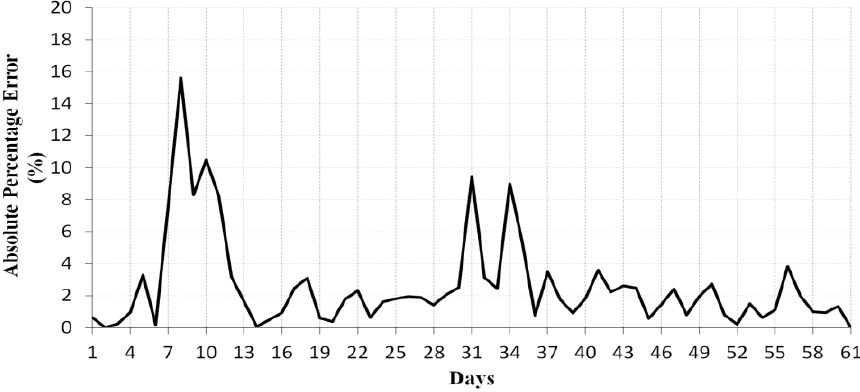
Figure 5. The lowest MAPE values achieved by the GWO-MLP method.